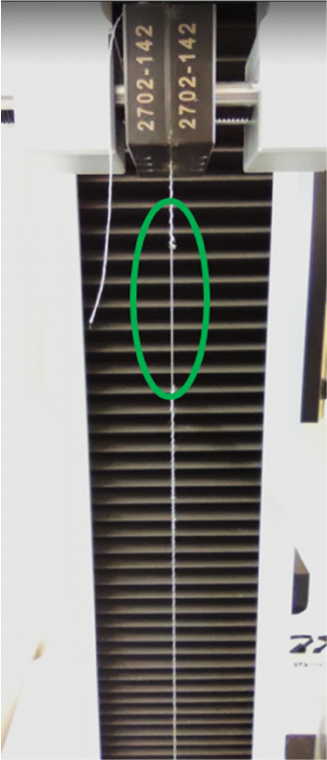
Figure 3. A sample of Silver-tech 50 tensioned beyond its first-stage fracture, still partially intact. The affected area is enclosed in the oval.